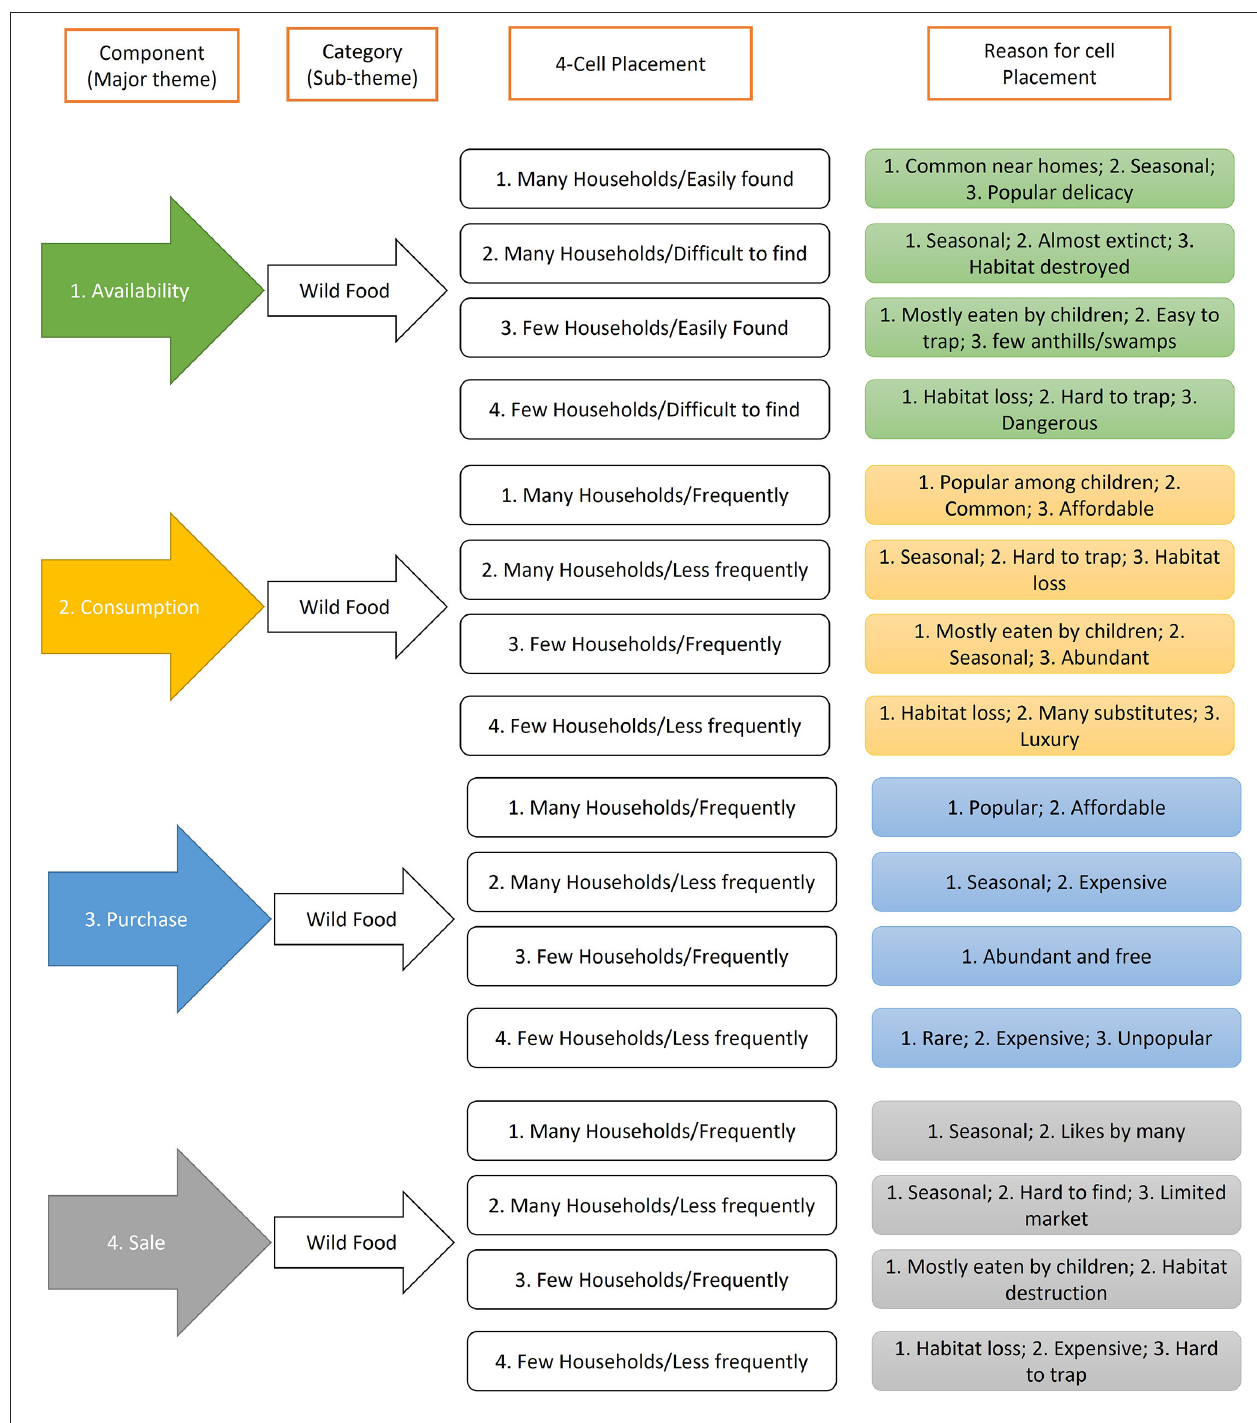
FIGURE 4 | Example reasons for the placement within the four different cells of the tool.